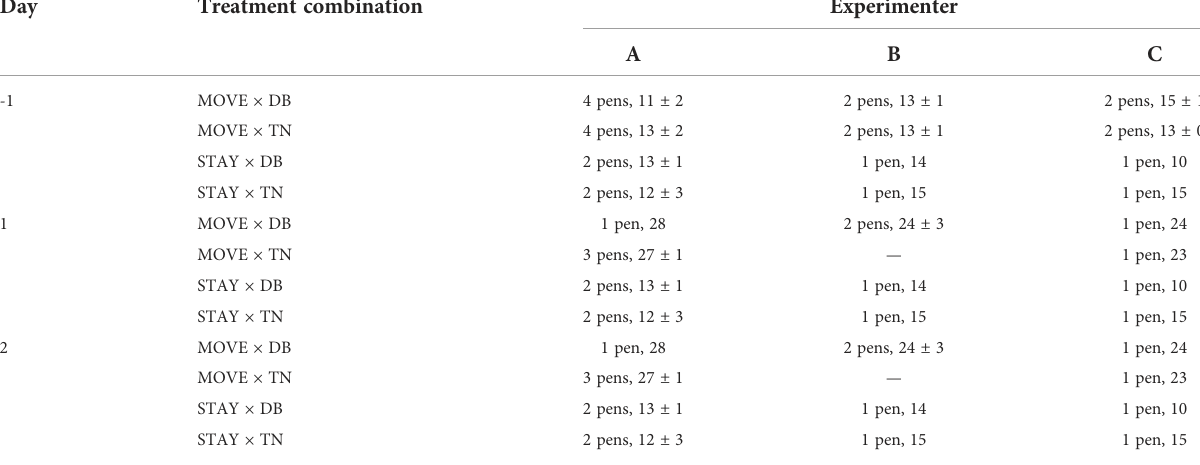
TABLE 3 Breakdown of the number of pens and pigs per pen following a 2 × 2 factorial arrangement of the factors weaning method (litters mixed in a conventional weaning pen; MOVE vs. litter stayed in the farrowing pen after removing the sow; STAY) and genetic hybrid (DanBred; DB vs. Topigs Norsvin TN70; TN) observed by each experimenter on each day ( − 1, 1, and 2) relative to weaning.